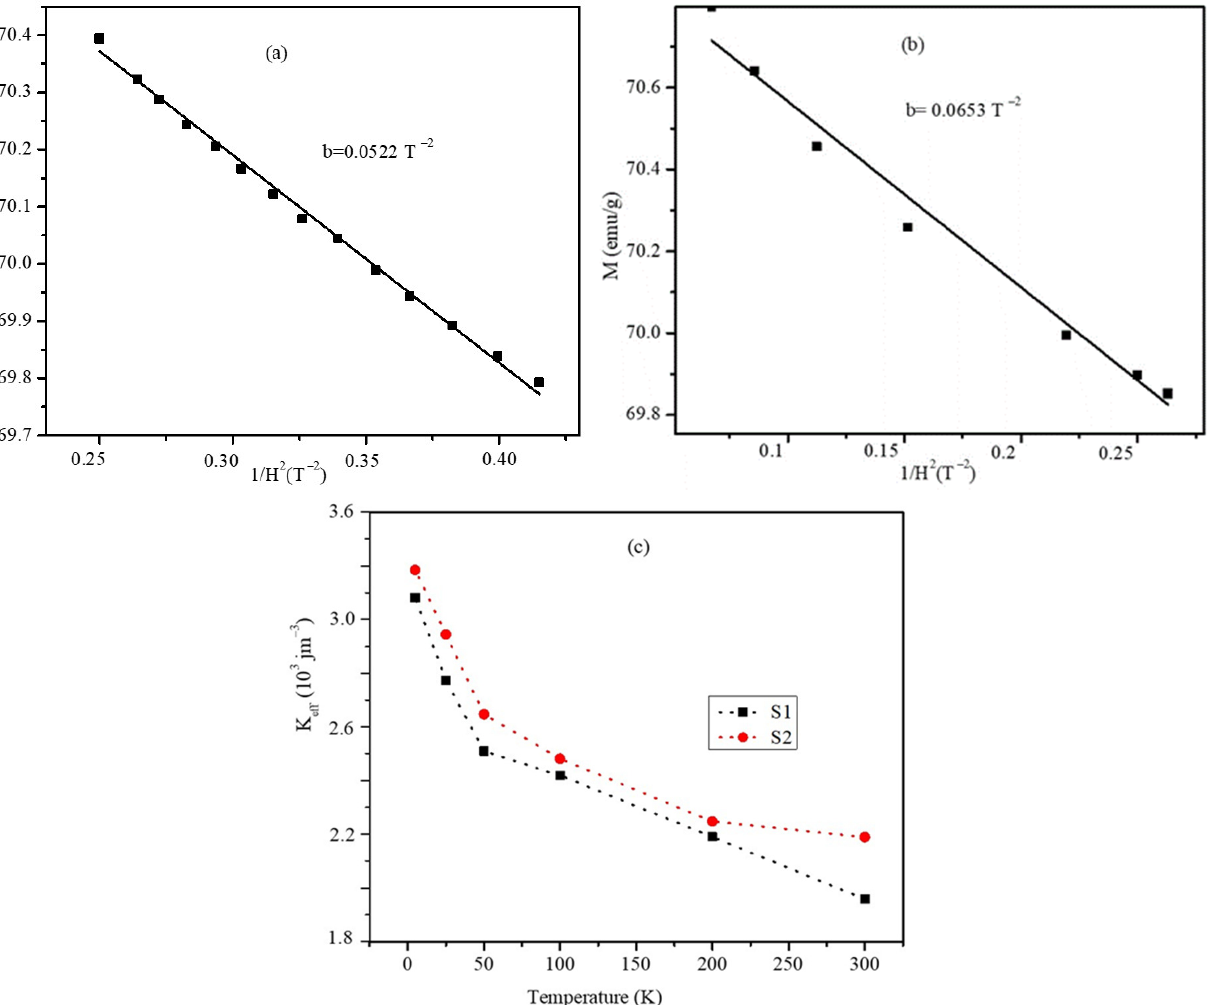
Figure 9. M vs. 1/H 2 plots obtained at high field strengths for the ( a ) S1 and ( b ) S2 nanoparticles at room temperature (experimental data are marked by symbols, and the solid lines represent a linear fit of the experimental data using Equation (4)). ( c ) Temperature-dependent K eff values of the S1 and S2 nanoparticles.